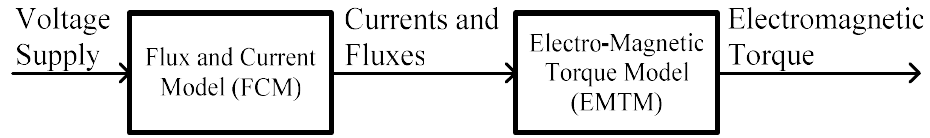
Figure 4. Block diagram of the 3 phase alternating current (AC) induction motor model.